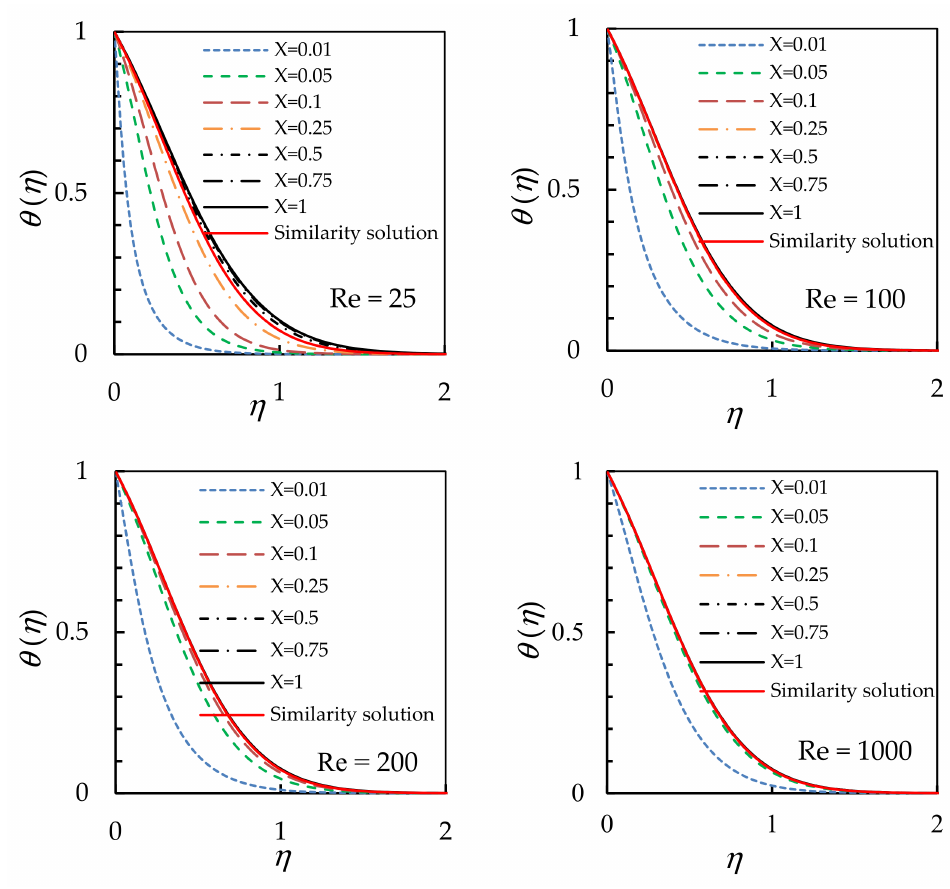
Figure 4. Effect of the Reynolds number on the temperature profiles at various locations along the sheet for Gr = 10 4 , Pr = 6.2, Le = 10, Nb = Nt = Nr = Rb = Ω = 0.1, and Pe = Lb = 1.